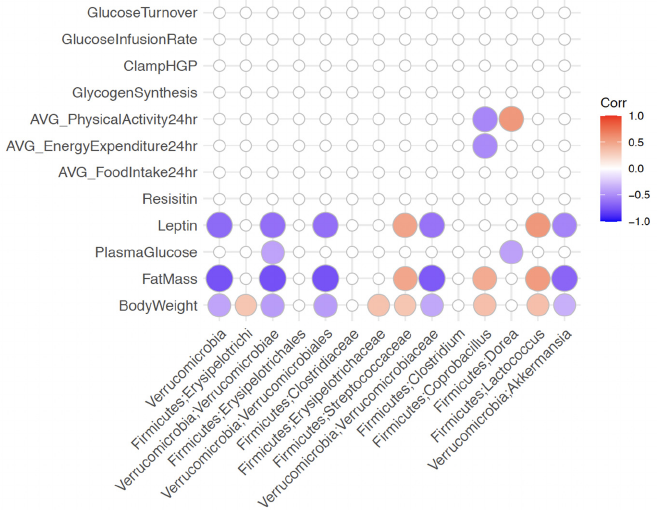
Figure 9. Metabolic changes correlate with multiple gut microbiota taxa in female mice. Spearman correlation tests were done on the taxa associated with E2 treatment. Red circles represent positive correlation whereas purple circles represent negative correlation, with increasing size of circles indicating stronger associations. q-value < 0.1 considered significant.